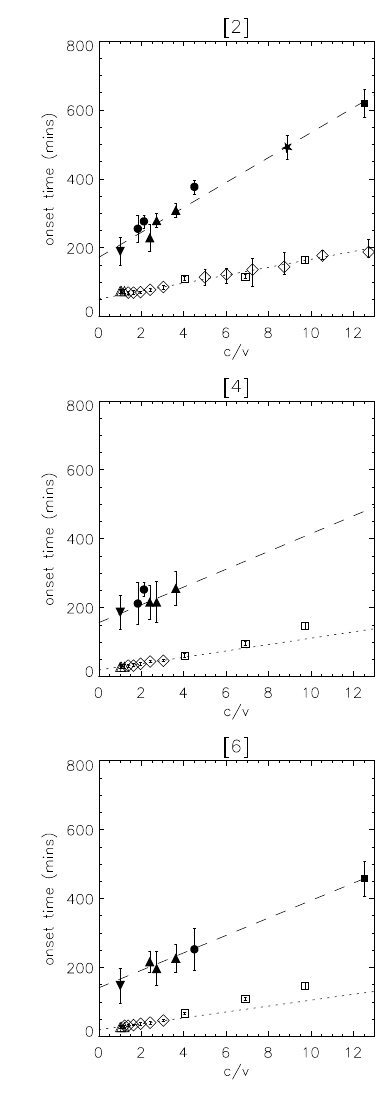
Fig. 2. Plots of onset time versus c/v near Earth (empty symbols) and at Ulysses (filled symbols). Details of the 9 events are given in Table 1. Onset times are given in minutes from the start time of the GOES SXR